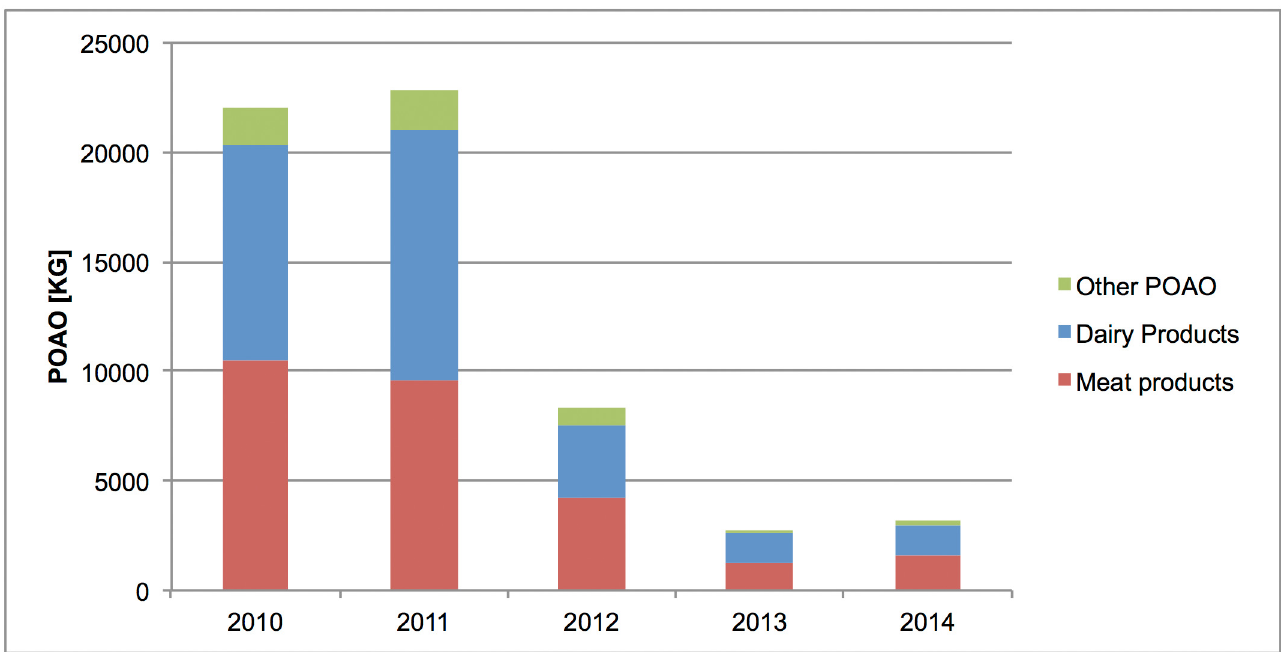
Fig 1. Total amount of seized POAO (in kg) and mean amount of kilogrammes per passenger at IA 1, 2010 – 2014.